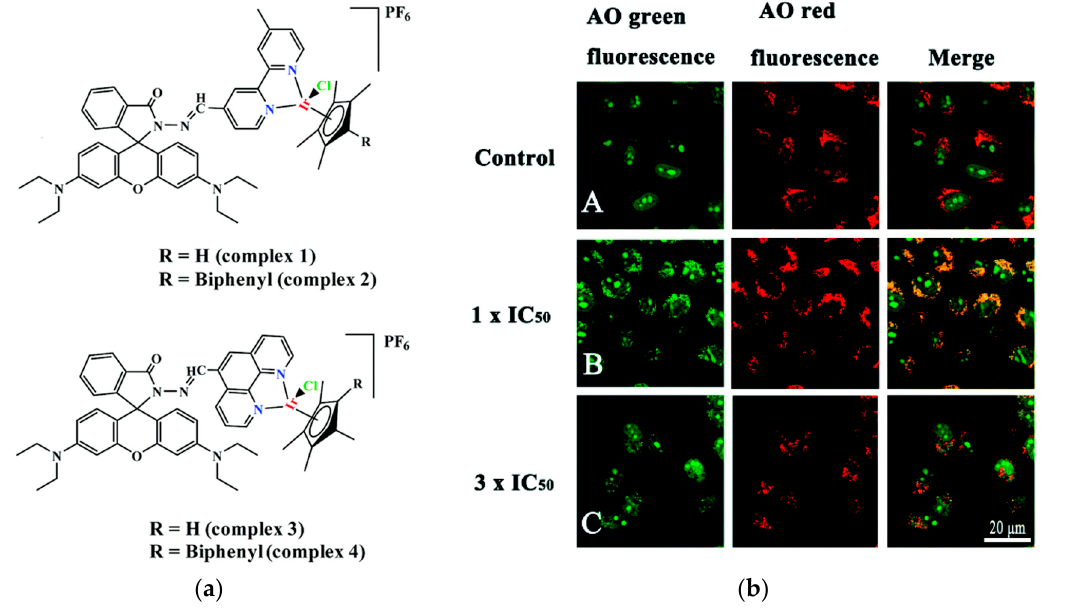
Figure 12. Ir-piano-stool anticancer drugs: ( a ) Structures of four iridium piano-stool rhodamine anticancer drugs; ( b ) Lysosomal membrane permeabilization in A549 cancer cells. A549 cells without ( A ), with 1 × IC 50 ( B ) and 3 × IC 50 ( C ) complex 3 and then stained with AO. Adapted with permission from [189].